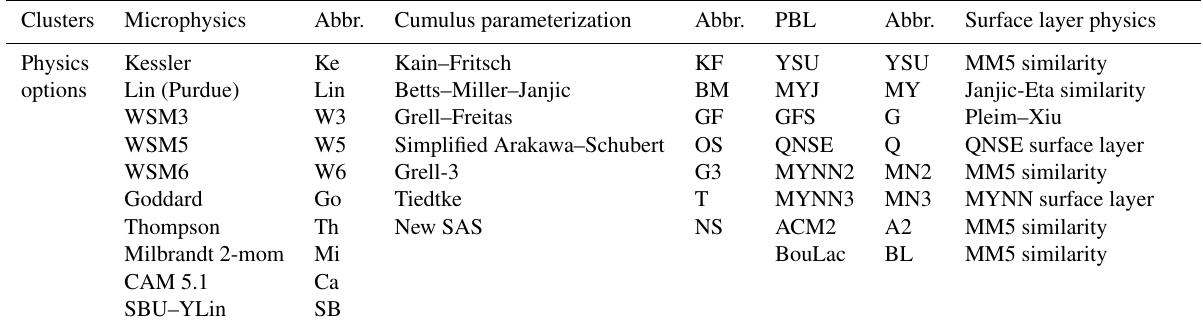
Table 1. Employed physics configuration of Set 1, which summarized 10 × 7 × 8 configurations. The abbreviation is followed by the physics name. The PBL is used with certain surface layer physics indicated in the same row of PBL option.